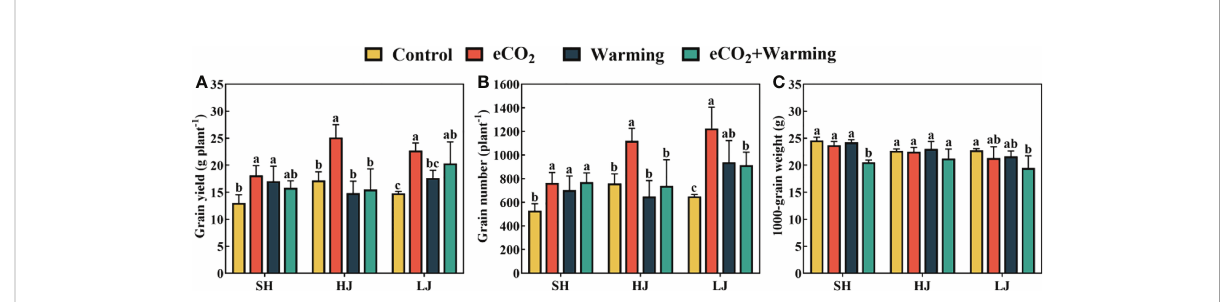
FIGURE 12 The rice yield (A) , grain number (B) and 1000-grain weight (C) of three rice cultivars grown under control, ambient conditions; e[CO 2 ], elevated CO 2 concentration; warming, elevated air temperature; e[CO 2 ] plus warming, the combination of elevated air temperature and [CO 2 ]. SH, HJ and LJ refer to three rice cultivars Shishoubaimao, Hejiang 19, and Longjing 31, respectively. Values are the means ± SEs (n = 3). Lower-case letters indicate signi fi cant differences between treatments at P < 0.05